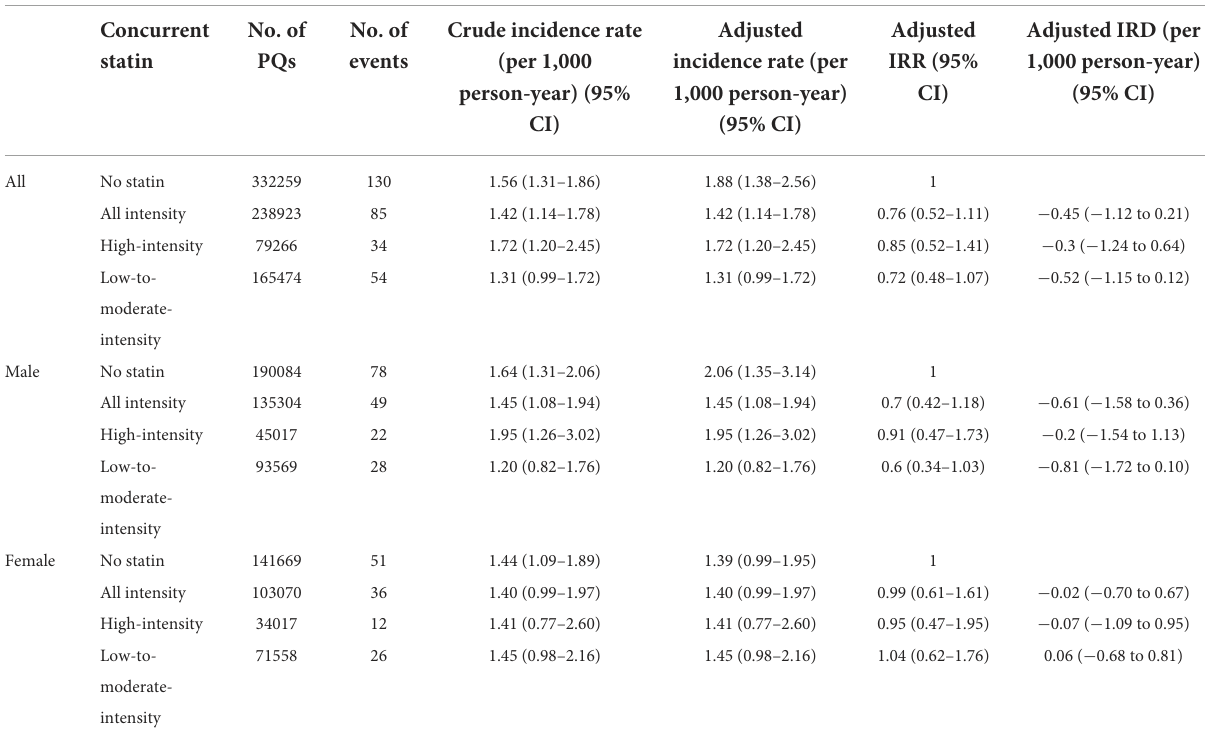
TABLE 6 Other sites bleeding among DOAC using